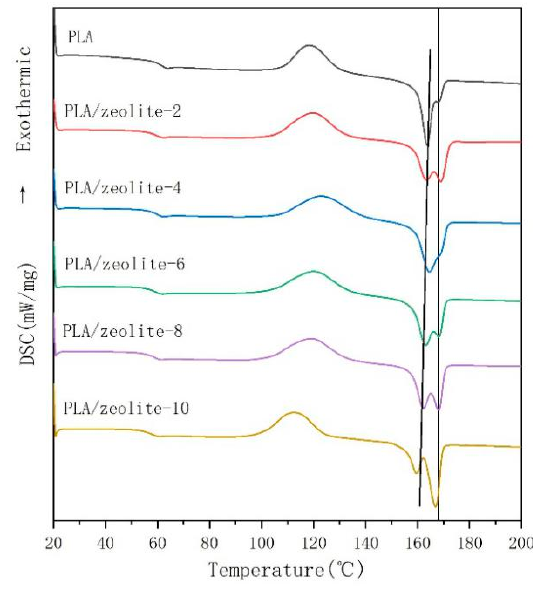
Figure 5. DSC second heating curve of PLA and PLA/zeolite composites.